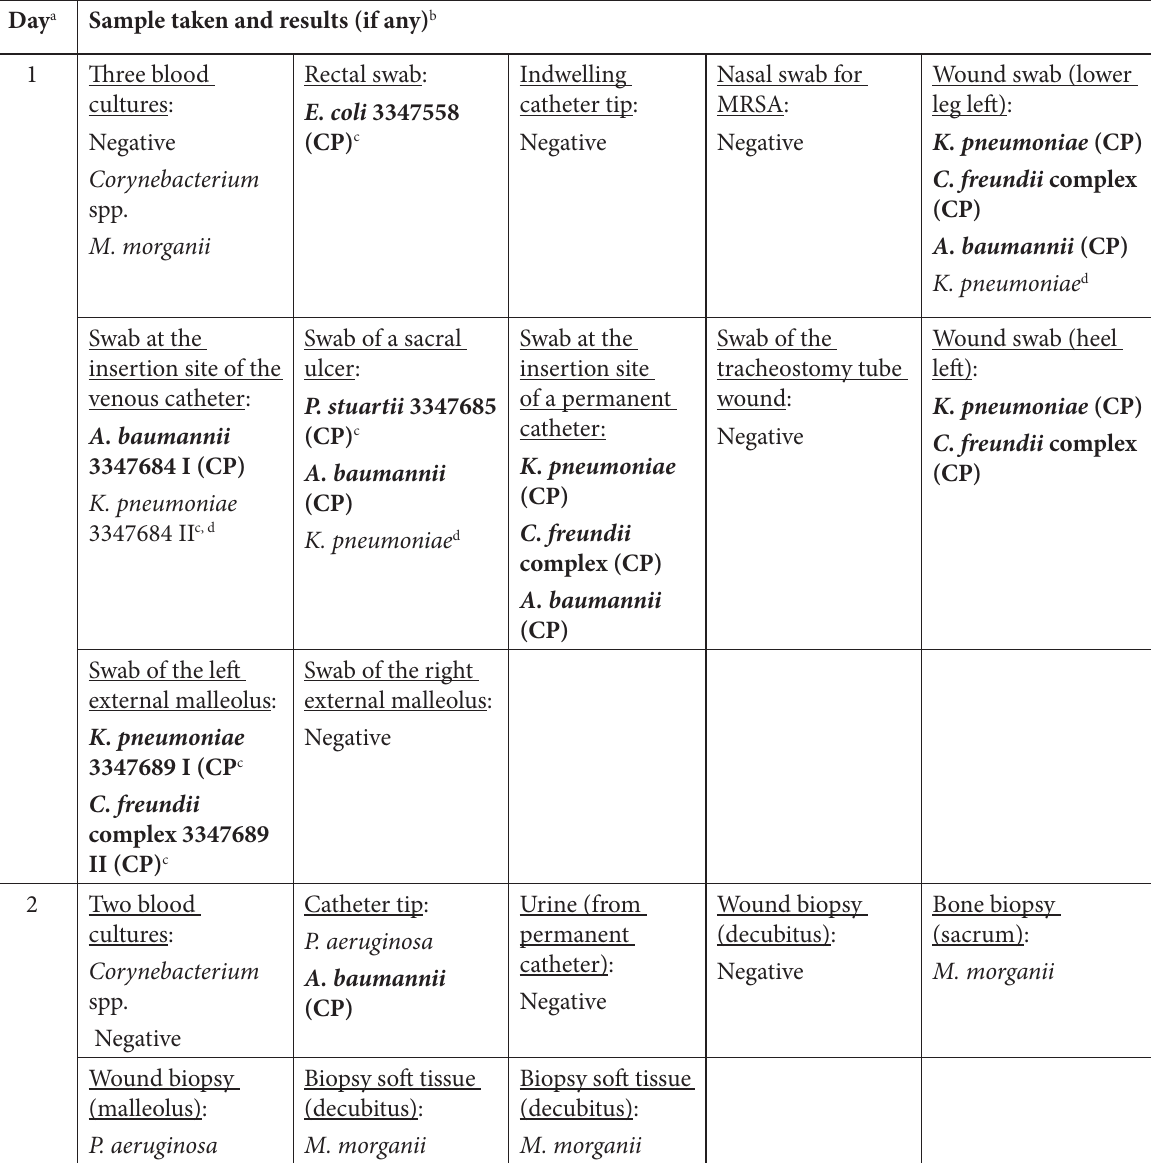
Table 1. Summary of the samples and bacteria isolated from the patient during the routine tests Day a Sample taken and results (if any)